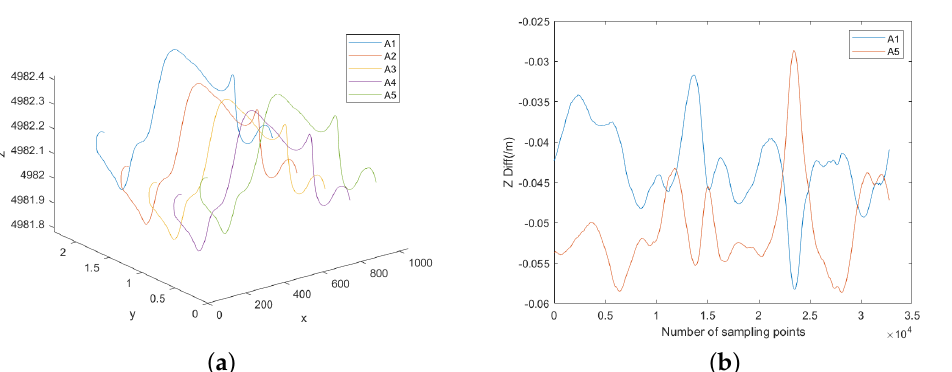
Figure 6. The change in the POS trajectory. ( a ) The POS trajectory; ( b ) the jitter trajectory of the flexible